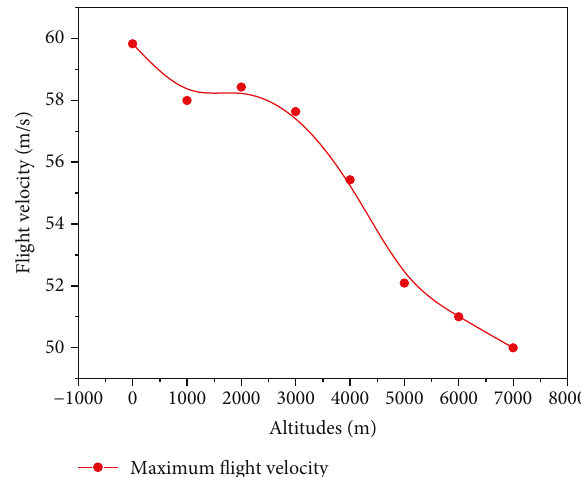
Figure 16: Stall speeds of UAV at di ff erent altitudes. Figure 17: Maximum fl ight velocity of UAV at di ff erent altitudes.